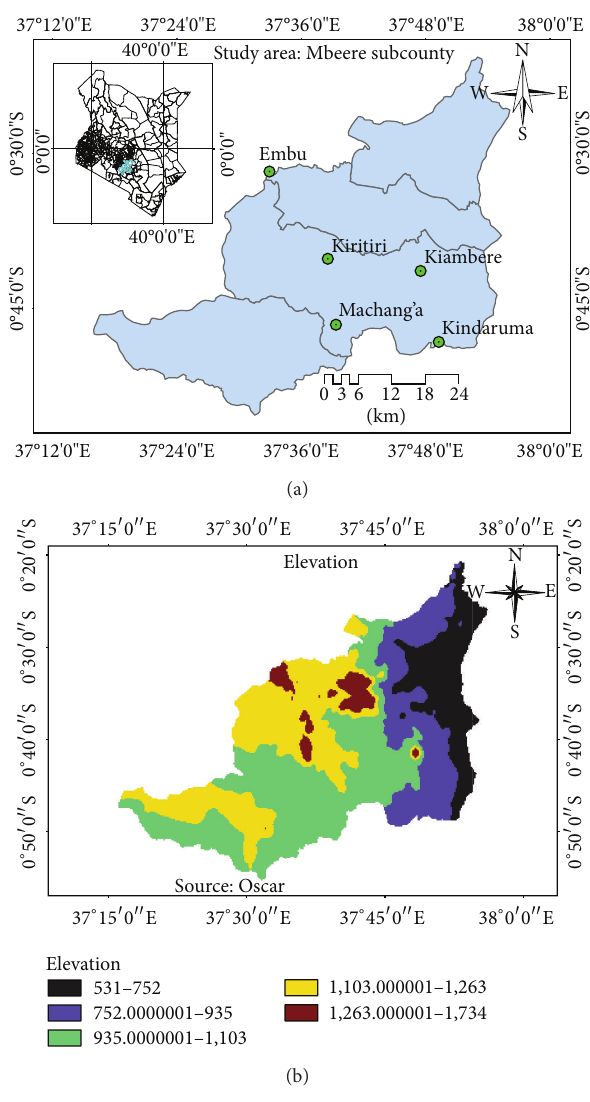
Figure 1: Map showing the study area and its elevation with studied point gauged rainfall data; Machang’a and Embu, Kiritiri, Kindaruma, and